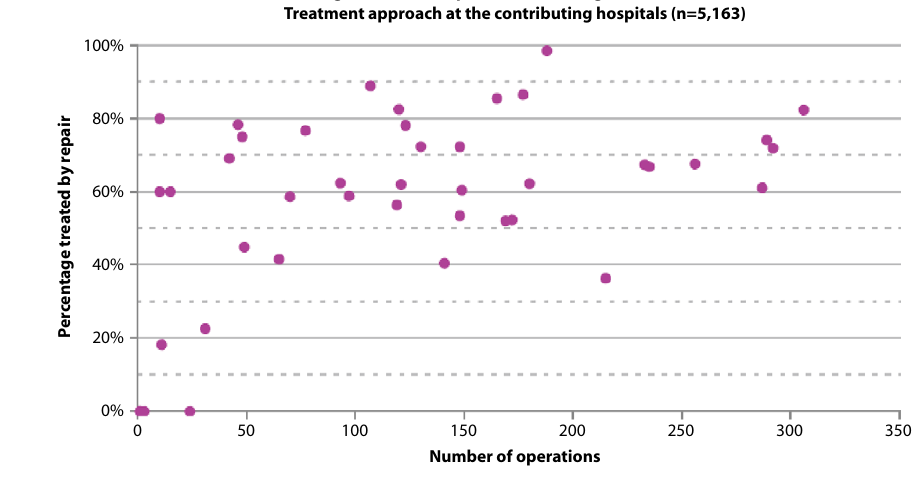
Figure. 4 The proportion of patients with degenerative mitral regurgitation treated by repair and replacement in theUKto2008.AcknowledgementBridgewaterB,KinsmanR,WaltonPandKeoghB.Demonstratingquality:The sixth National Adult Cardiac Surgery database report: Publisher Dendrite Clinical Systems Ltd. ISBN 1-903968- 23-2. 2009. Ref.